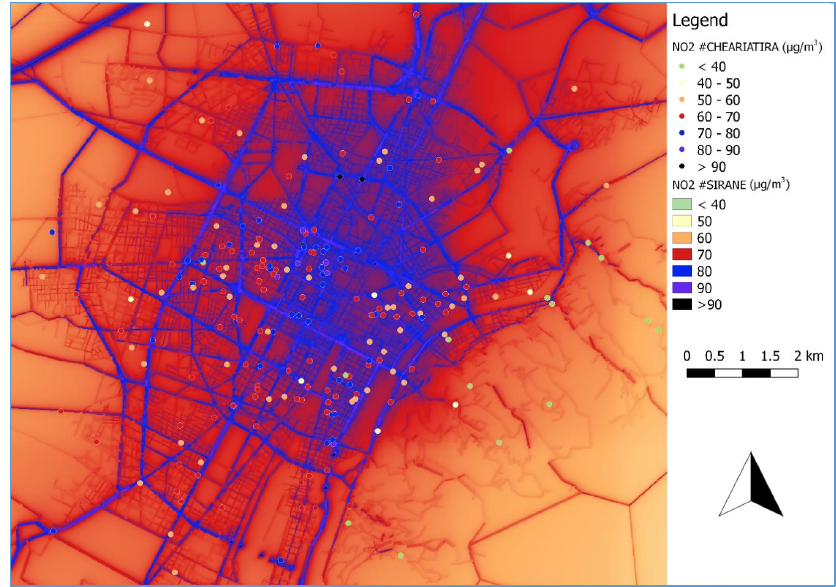
Figure 9. Map of average NO 2 concentrations modelled by SIRANE with #CHEARIATIRA samples for the campaign period (elaboration by means of QGIS 2.18).